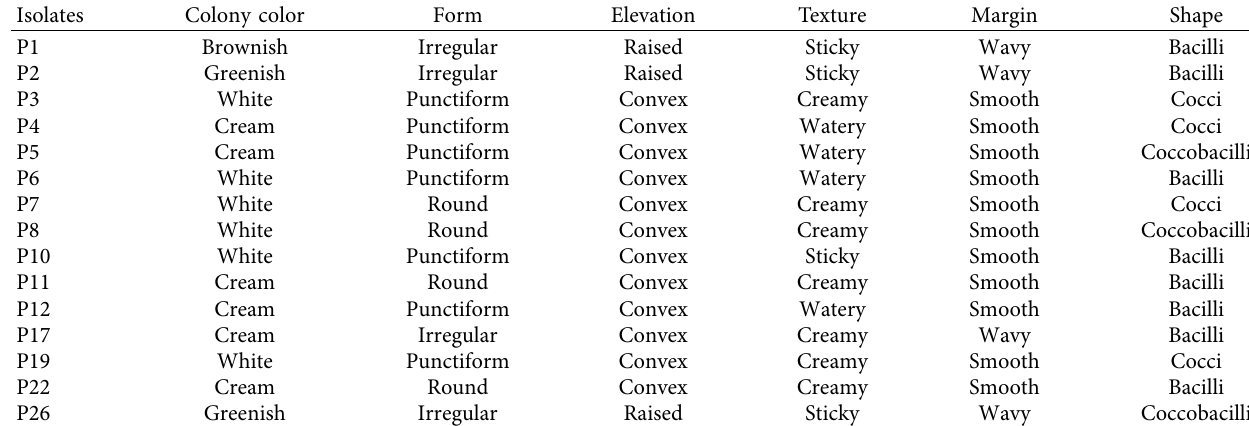
Table 3: General morphology and characteristics of 15 isolated bacteria.